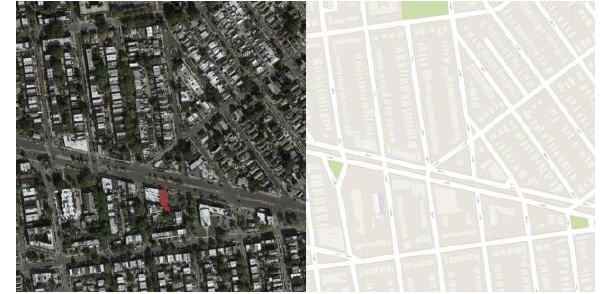
Figure 8. Remote sensing image conversion network